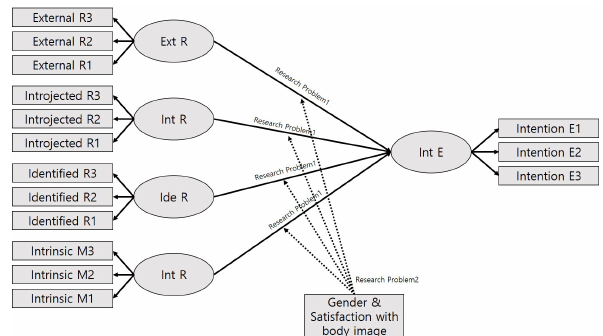
Fig. 1. Research structural model.